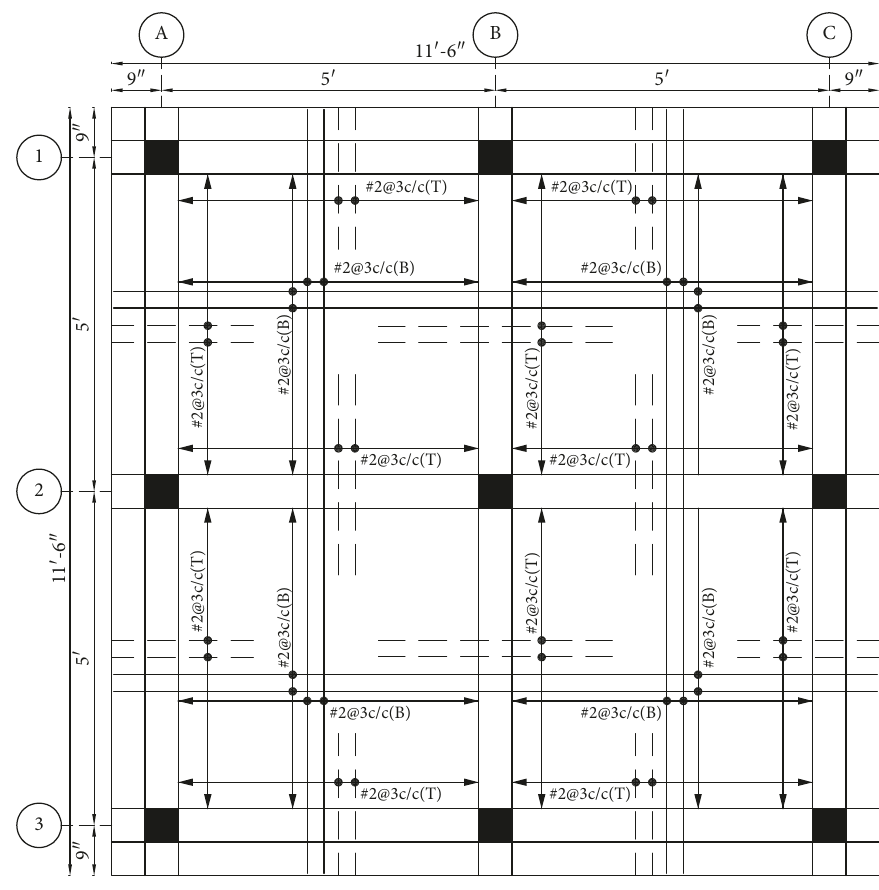
Figure 6: Plan view of first- and second-storey specimens with slab reinforcement